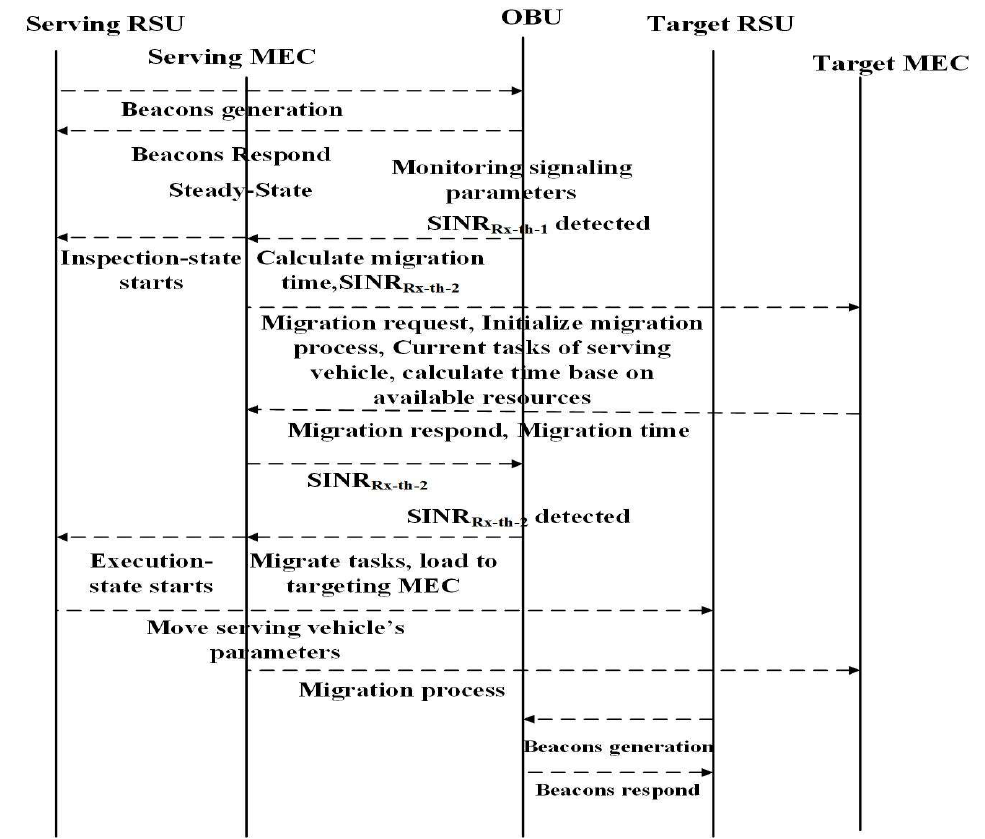
Figure 4. Signaling flow of the developed handover scheme.